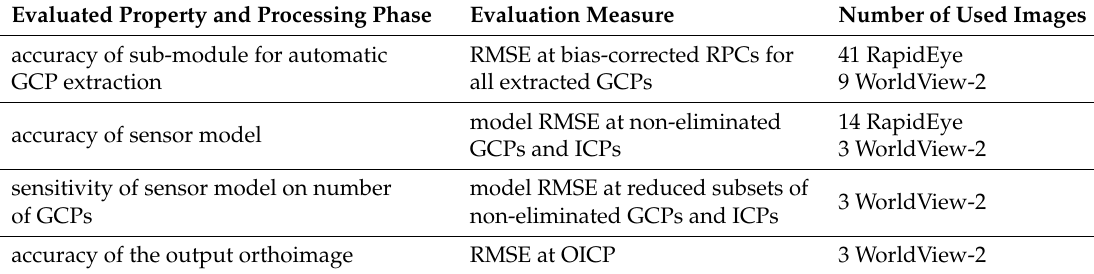
Table 3. Used accuracy evaluation measures. RMSE is root-mean-square error. RPCs are rational polynomial coefficients. Ground control points (GCPs) were automatically extracted. Independent check points (ICPs) and "orthoimage ICPs" (OICPs) were manually digitized from satellite image and national aerial